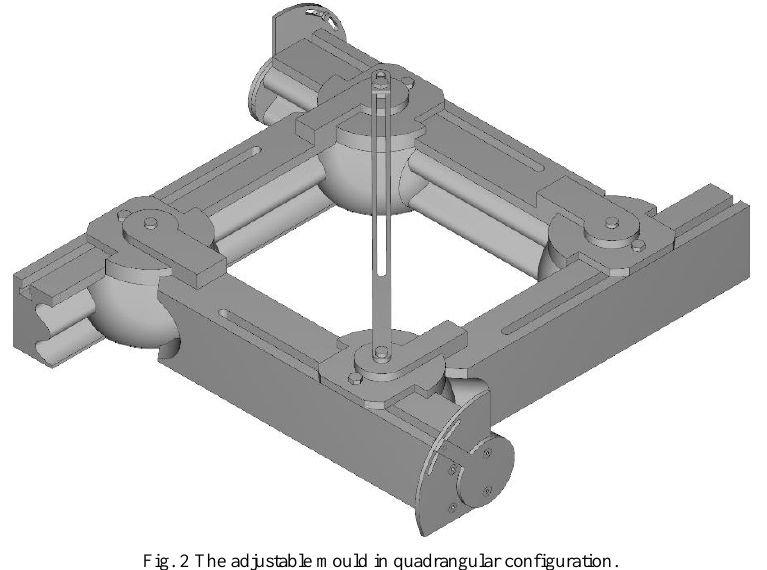
Fig. 2 The adjustable mould in quadrangular configuration.